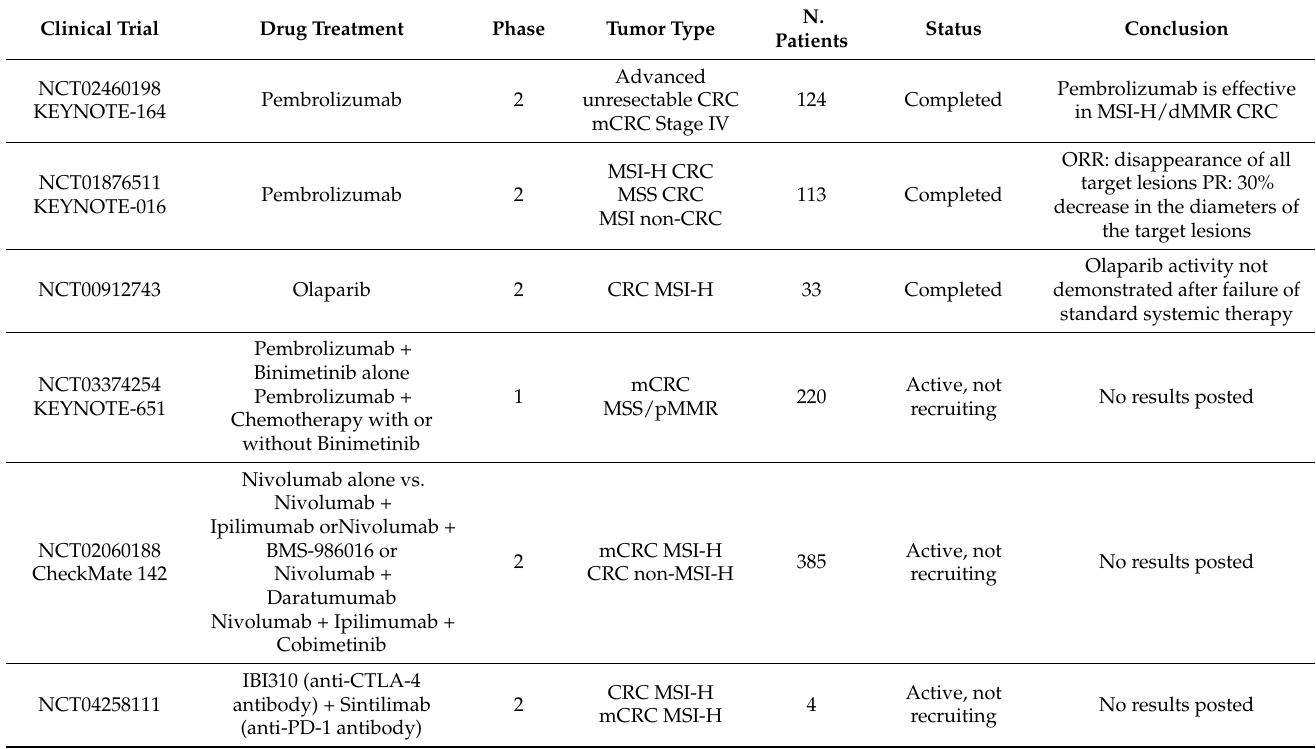
Table 1. Clinical trials for immune checkpoint inhibitors treatment of MSI